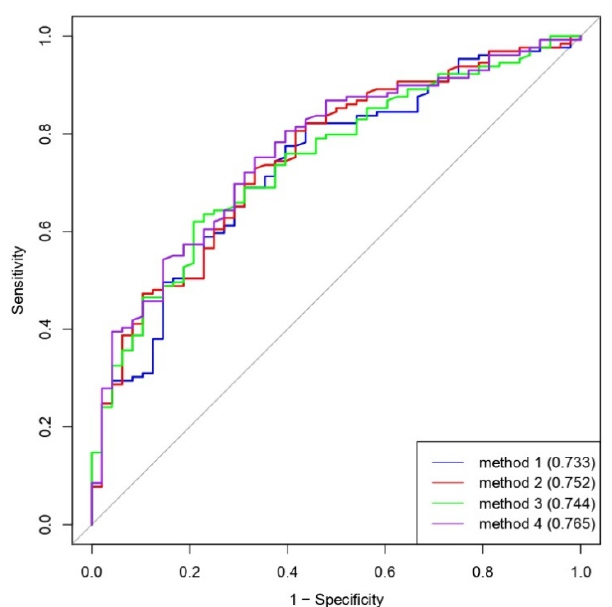
Figure 5. The receiver operating characteristic (ROC) curves of all four measurement methods.